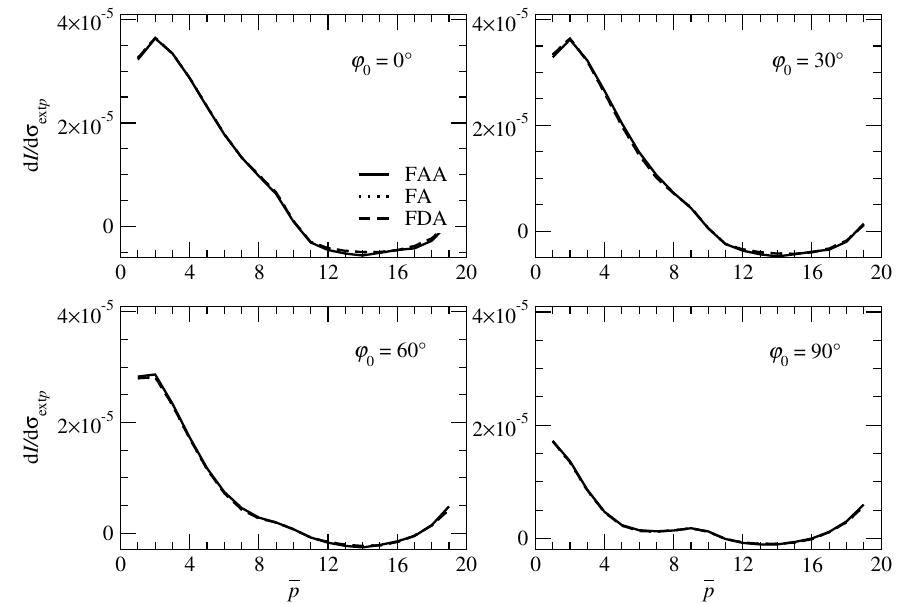
z = L z /2), p = 1,...,19, t ,